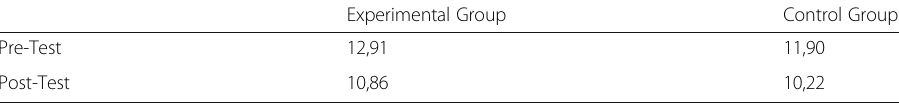
Experimental Group Control Group